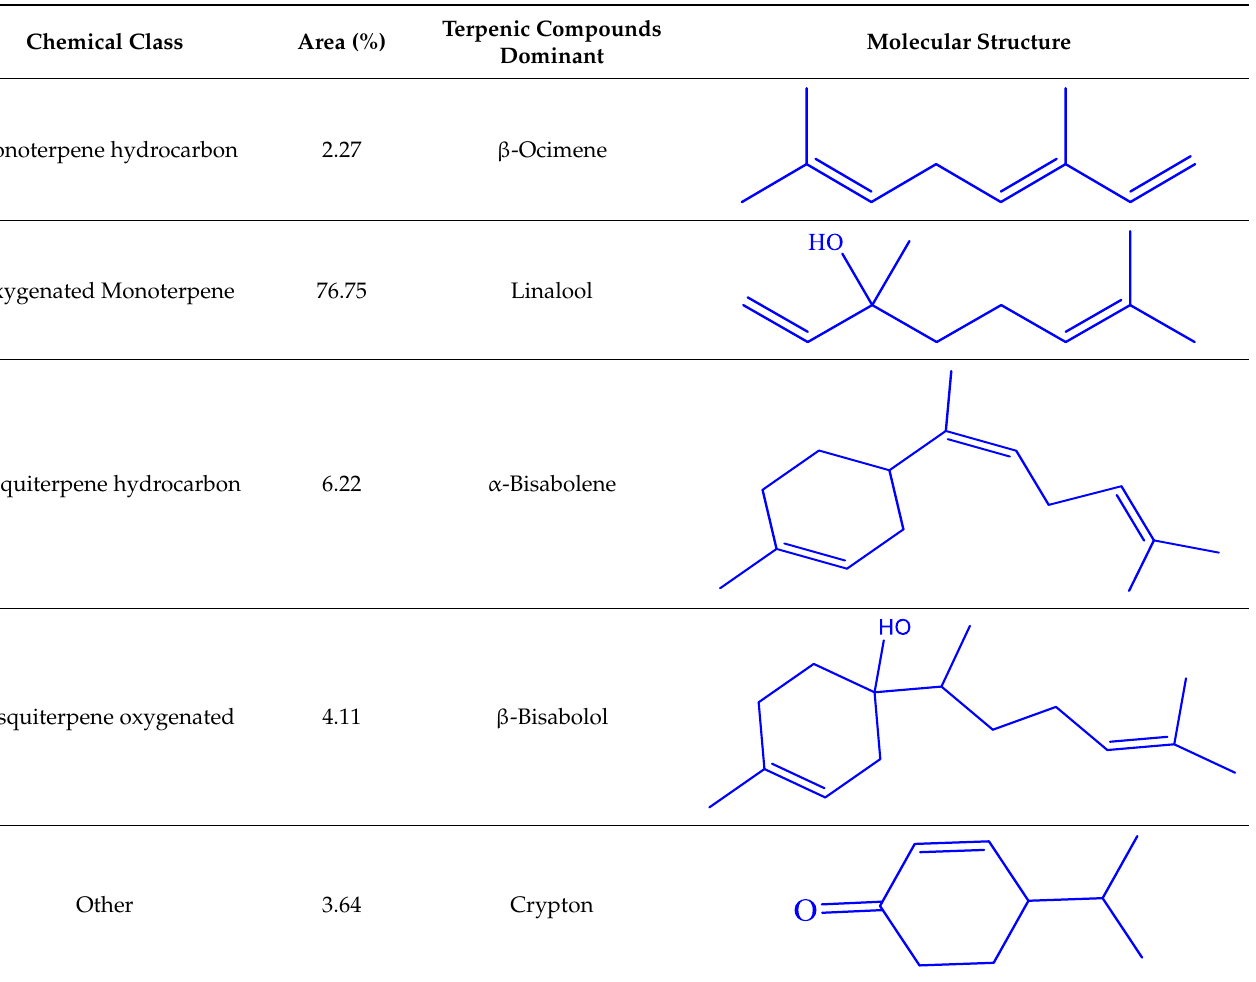
Table 2. Chemical class of the dominant phytochemicals identified in EOBD. Chemical Class Area